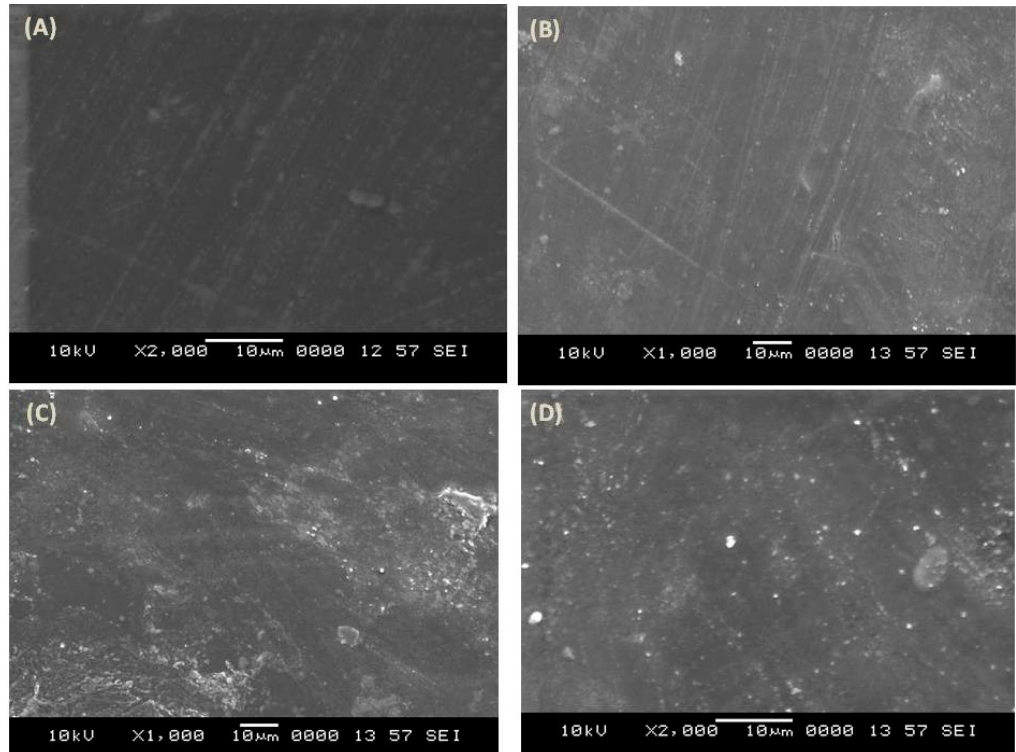
Figure 5. SEM images of ( A ) Plain PVA, ( B ) PVA-ZnO-2.5%, ( C ) PVA-ZnO-5 and ( D ) PVA-ZnO-7.5% membranes.